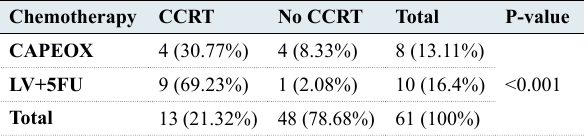
Table 6: Chemotherapy for patients receiving radiation in CRC in AYA Chemotherapy